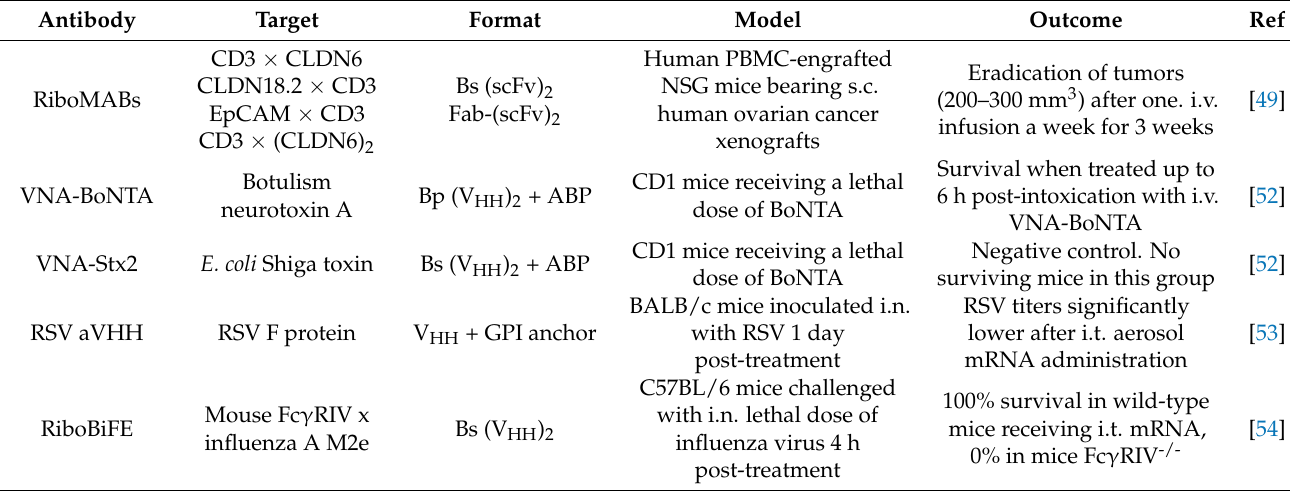
Table 3. mRNA-encoded antibody fragments in preclinical